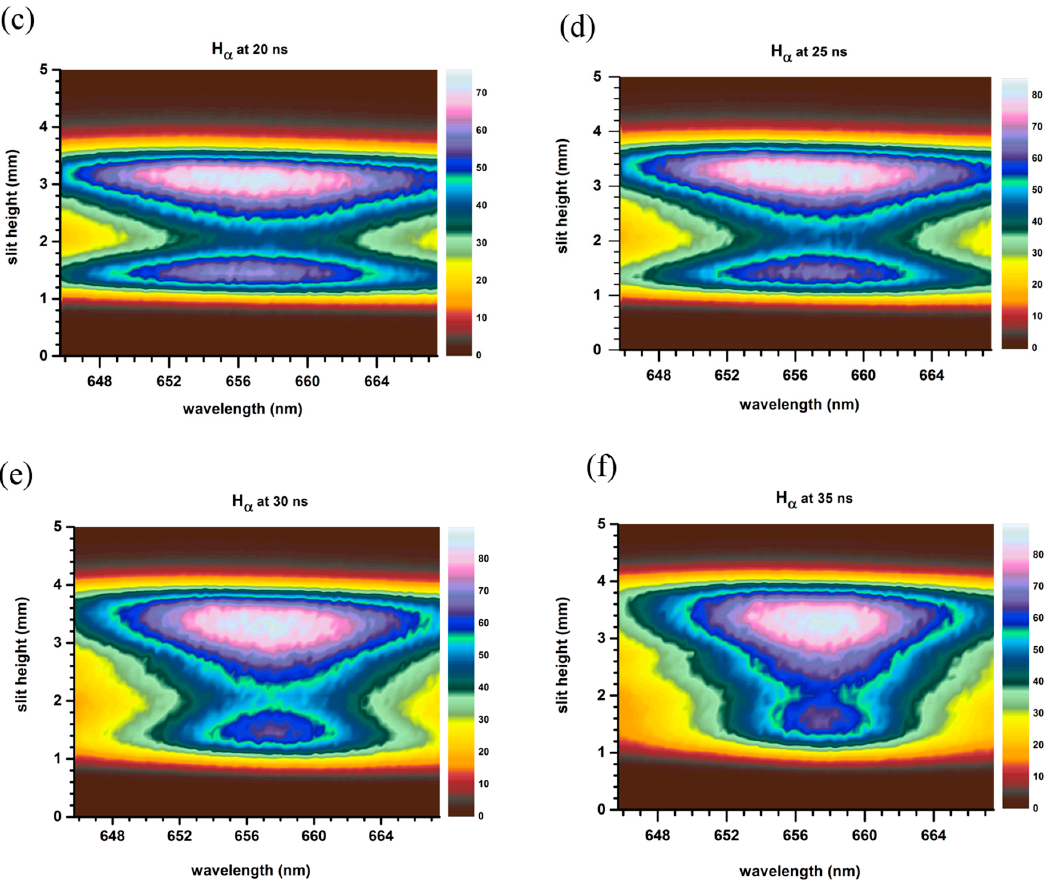
Figure 1. Hydrogen alpha plasma spectra images for selected time delays: ( a ) 10 ns; ( b ) 15 ns; ( c ) 20 ns; ( d ) 25 ns; ( e ) 30 ns; and ( f ) 35 ns.